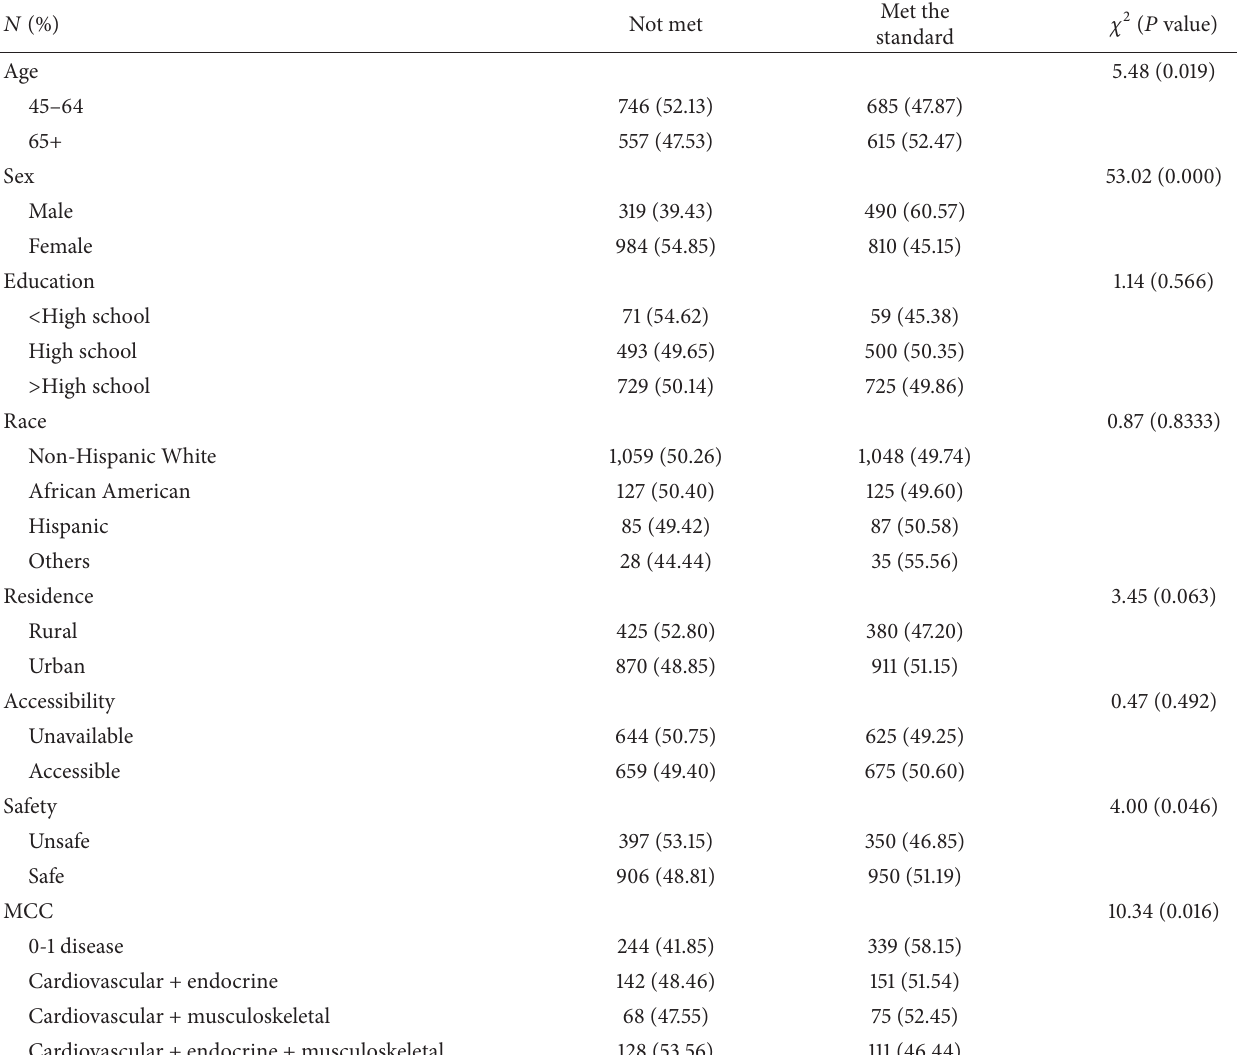
Table 2: Association between the level of physical activity and personal characteristics, environmental factors, and combinations of chronic